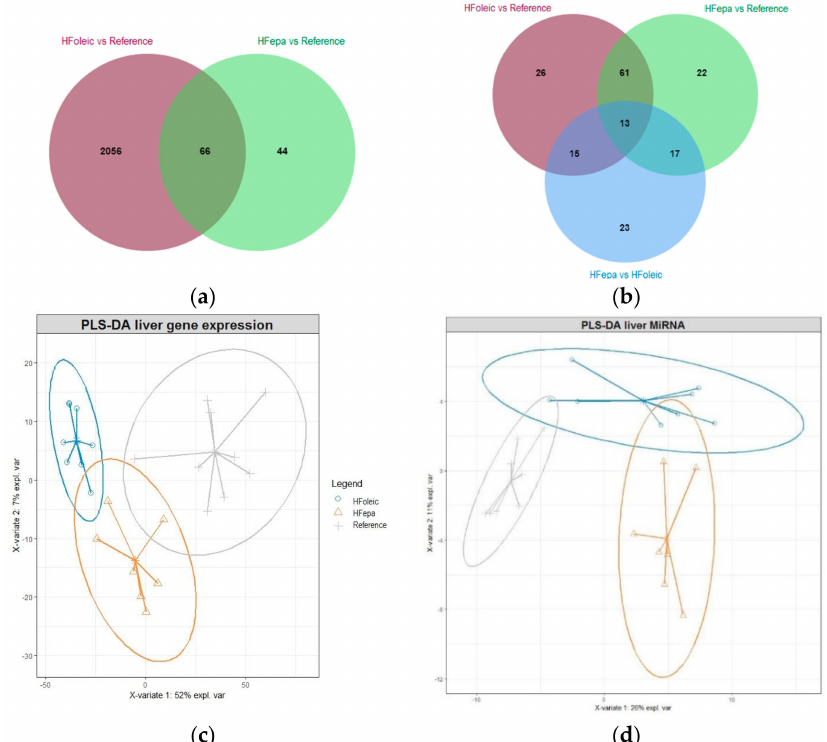
Figure 2. E ff ect of High Fat Diet and transgenerational supplementation with EPA in gene and miRNAs expression. ( a ) Venn diagram showing the relationships in the number of genes di ff erentially expressed between HFepa vs. reference and HFoleic vs. reference biological condition. ( b ) Venn diagram showing the relationships in the number of miRNAs di ff erentially expressed between three biological conditions, HFepa vs. reference, HFoleic vs. reference and HFepa vs. HFoleic. ( c ) Di ff erentially expressed genes from three group biological condition, HFepa vs. reference, HFoleic vs. reference, HFepa vs. HFoleic were used to perform a partial least squares regression-discriminant analysis (PLS-DA). ( d ) PLS-DA analysis of di ff erentially expressed miRNAs from three biological conditions, HFepa vs. reference, HFoleic vs. reference, HFepa vs.